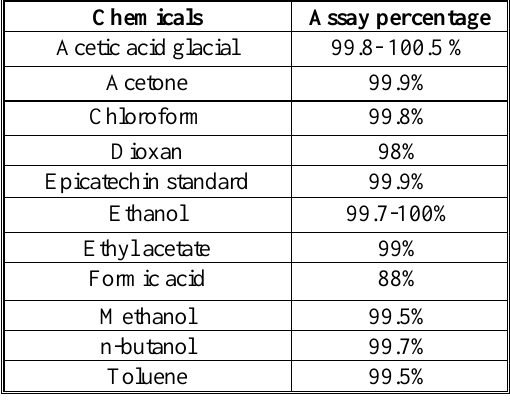
Table 1. Chemicals and standard used with assay